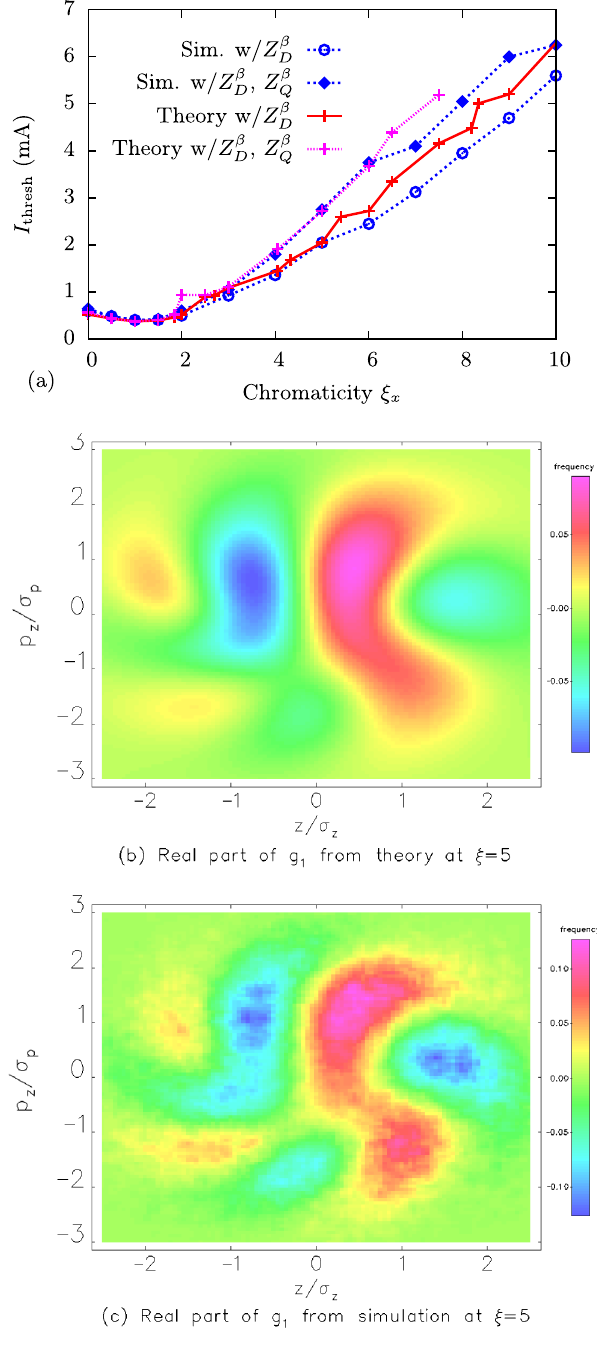
FIG. 6. Comparison of theory and simulation including the quadrupolar impedance. (a) plots the current limit with and without the quadrupolar impedance, which for the resistive wall β elements of Table I has Z β ð k Þ ≈ − Z ð k Þ = 2 . Including Z Q D Q increases I by 10 – 40% at large chromaticity. (b) plots the thresh real part of the unstable growing mode obtained from the 5 , which should be compared to the theory simulation with ξ x ¼ in panel (c). The unstable ~ g 1 has ∼ 35% of the basis functions with m ¼ − 4 and ∼ 30% with m ¼ − 3 , and a broader range of azimuthal variation then the purely dipolar impedance example of Fig.